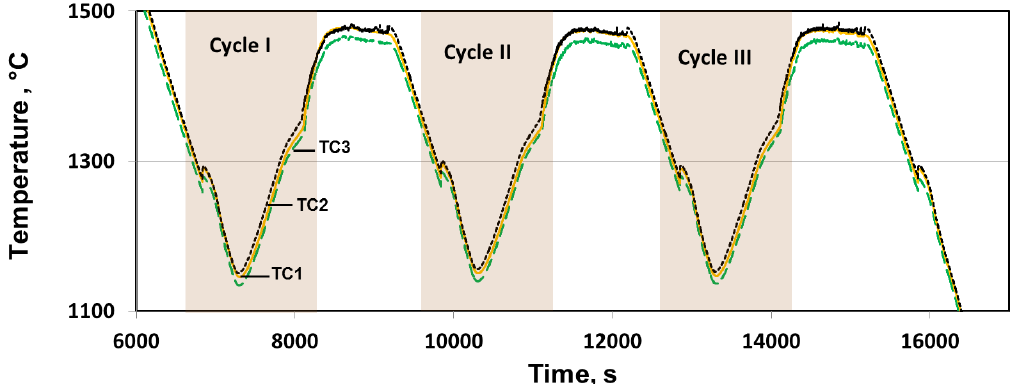
Figure 7. Temperature measurements for one alloy, three different thermocouples and three